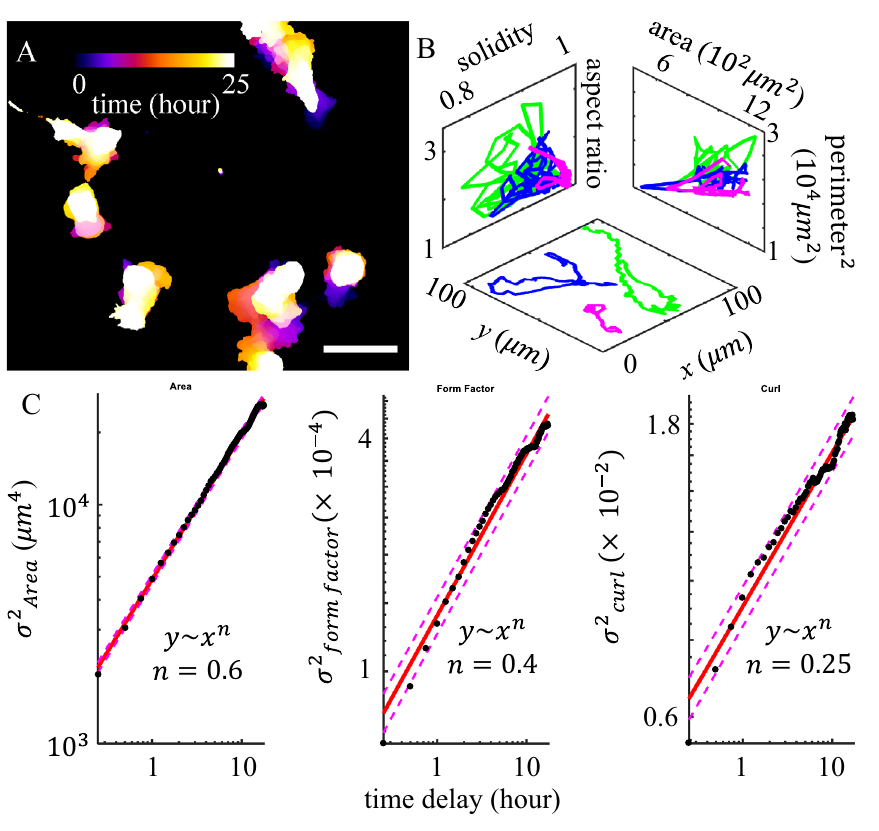
Figure 1. Three-dimensional migration of MDA-MB-231 cells show significant cell shape fluctuation. ( A ) A typical time lapse recording of 25 h is projected onto a single image with colors representing time. ( B ) The real space (x–y plane), and shape fluctuations of 3 cells shown in ( A ). ( C ) The mean square displacement ( σ 2 ) of selected cell geometric measures. Dots: experimental measurements. Solid lines: linear fit. Dashed lines: 95% prediction interval. Here the form factor is defined as perimeter 2 / area . Curl is defined as the ratio between the major axis length and skeletonized contour length. This figure is prepared with Matlab R2020a (www. mathw orks. com) and ImageJ (https:// imagej.